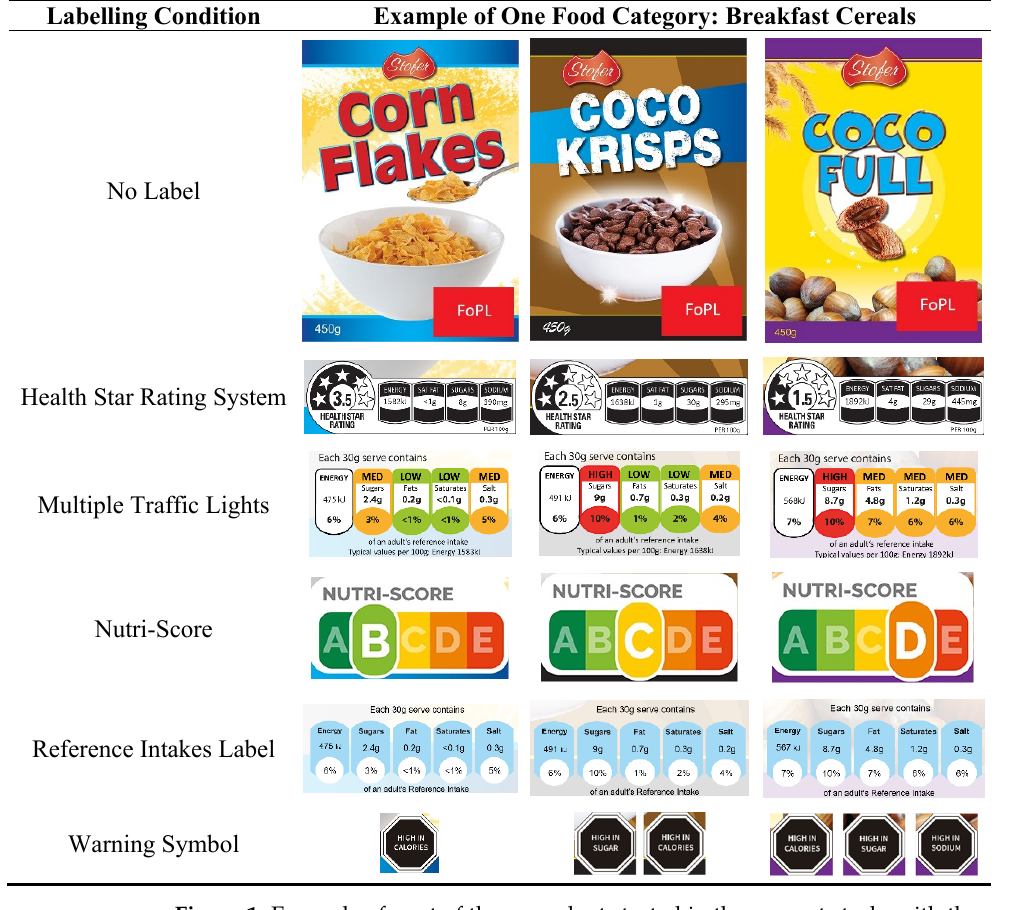
Figure 1. Example of a set of three products tested in the present study with the associated FoPLs (Front-of-pack labels).